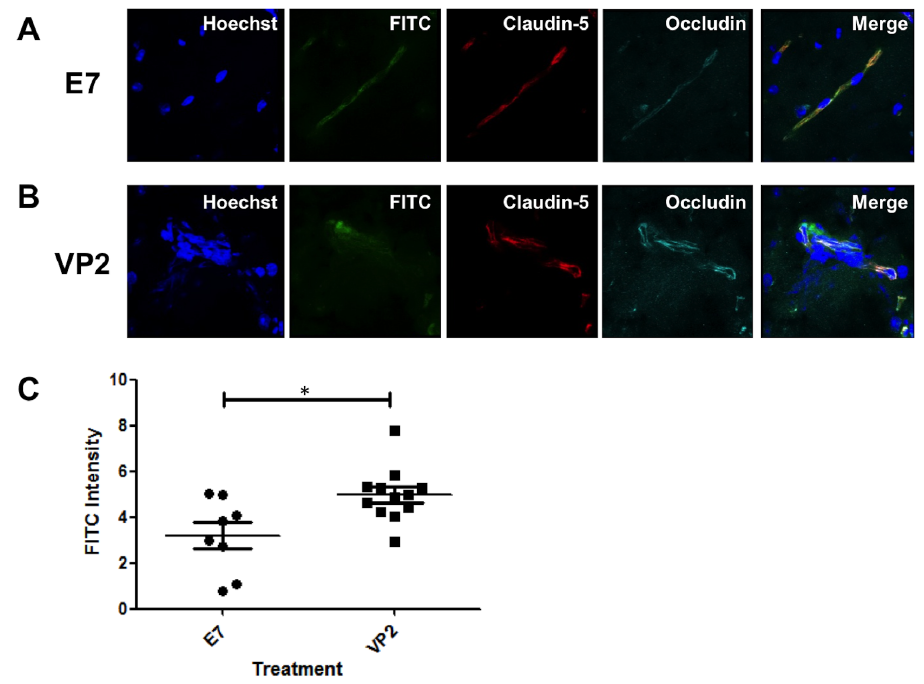
Figure 4. Disorganization of tight junction proteins and increased CNS vascular permeability can be induced in perforin 2 / 2 mice reconstituted with perforin competent CD8 T cells. Confocal microscopic images from a representative (A) mock E7 peptide-treated C57BL/6 perforin 2 / 2 mouse reconstituted with perforin competent CD8 T cells depict a preservation of vascular integrity and intact tight junction proteins claudin-5 and occludin. (B) VP2 121–130 peptide-treated C57BL/6 perforin 2 / 2 mice reconstituted with perforin competent CD8 T cells display degradation of tight junction proteins claudin-5 and occludin in areas of CNS vascular permeability as seen through FITC-albumin leakage. (C) FITC intensity in brain tissue from two representative confocal microscopic images of each animal was quantified using ImageJ software. VP2 121–130 peptide-treated mice (n=6) displayed a significant higher intensity of FITC-albumin in brain parenchyma when compared to E7 peptide-treated mice (n=4) (p , 0.05).